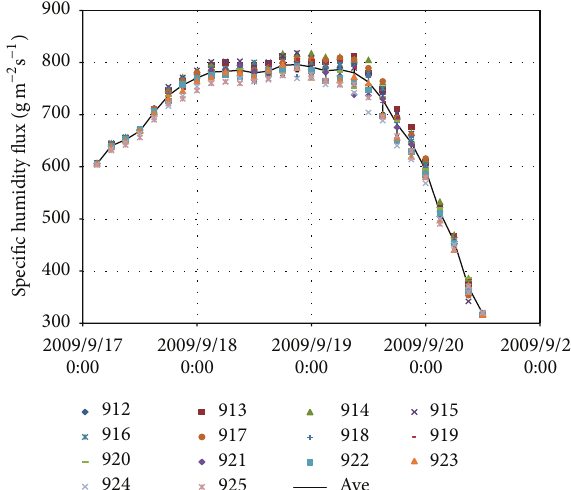
Figure 7: Time series of the mean horizontal specific humidity flux of the 14 simulations averaged over the area between altitudes of 20 to 2110m (corresponding to model levels 2 to 13) and between radii of 50 and 150km from the maximum wind speed. The values of each experiment are shown along with the average of the 14